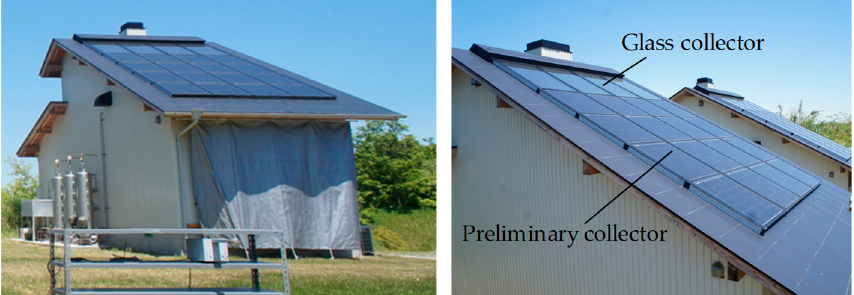
Figure 4. Target collector. Reproduced from [20], publisher: 2018.